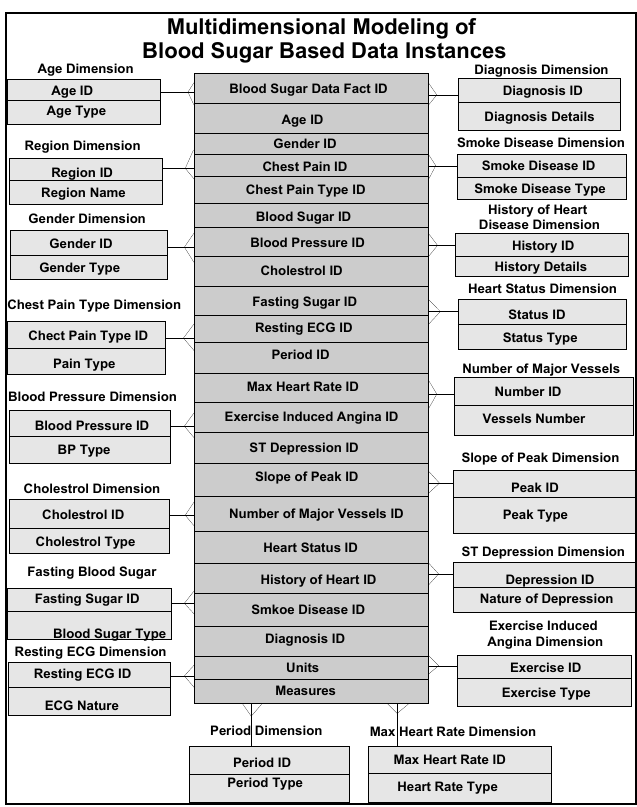
Figure 4. Multidimensional modeling of blood sugar data instances.